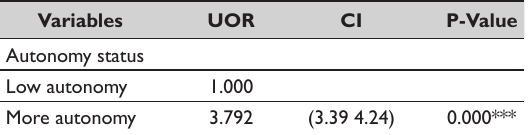
Table 4: Logistic regression analysis for ANC